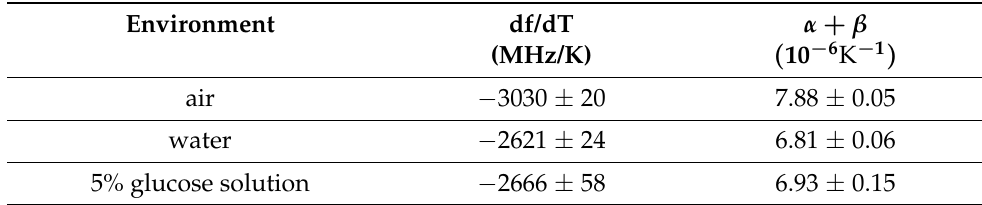
Table 1. Measured WGMR resonance shifts from temperature and the sum of α and β coefficients in air and water and glucose solution drops.